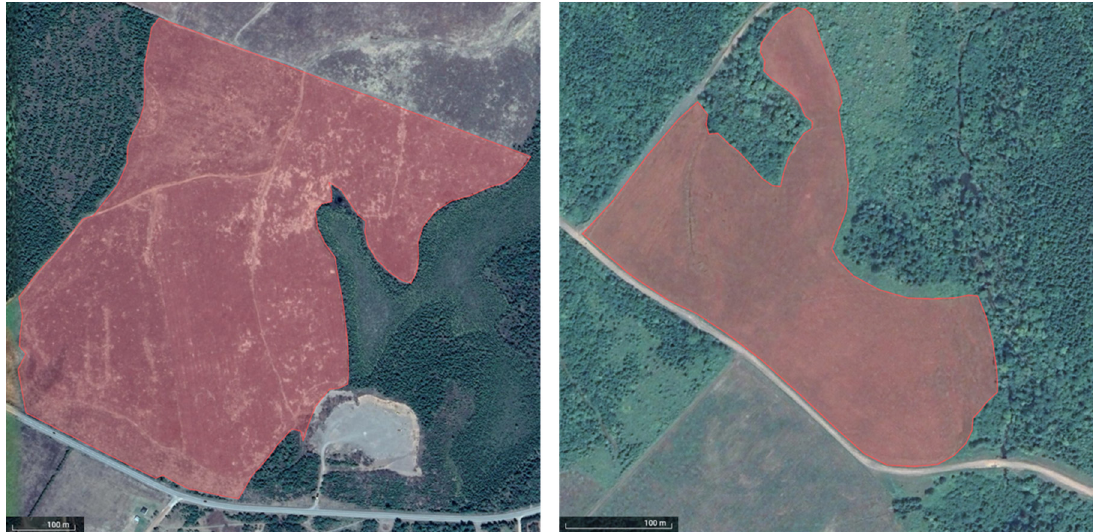
Figure 4. Boundary maps for Portapique ( left ) and Antigonish ( right ) fields.